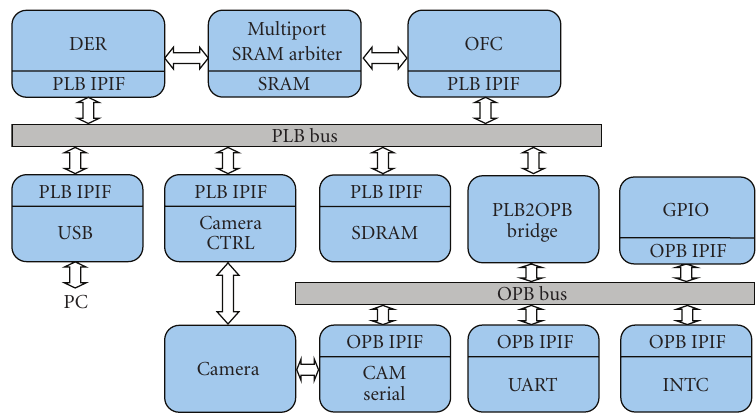
Figure 1: System hardware